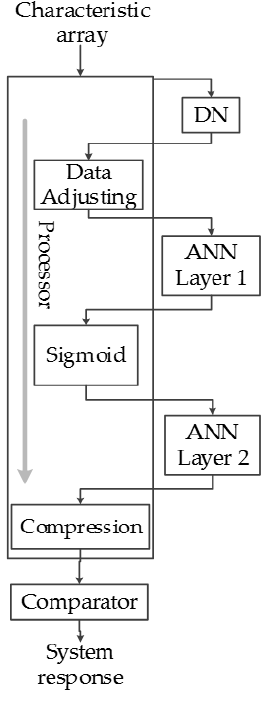
Figure 21. Classification system data flow.